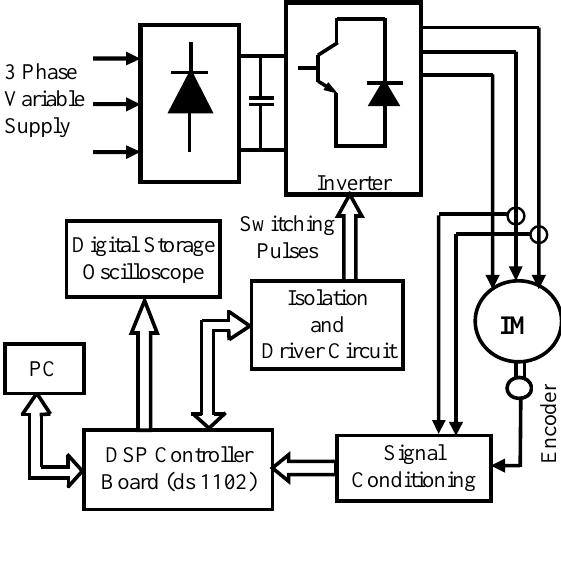
Fig. 13. Block diagram of the real-time implementation of the proposd wavelet-fuzzy based